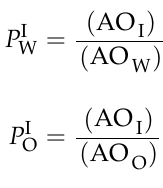
Figure 11. Partitioning of antioxidants in emulsions according to their polarity. In general, two par- tition constants are needed to de fi ne their distributions, but two limiting situations where only one partition constant is needed can be found. The fi rst limiting situation when considering very hydro- philic antioxidants (e.g., phenolic acids) is that they are essentially oil-insoluble and only P WI is